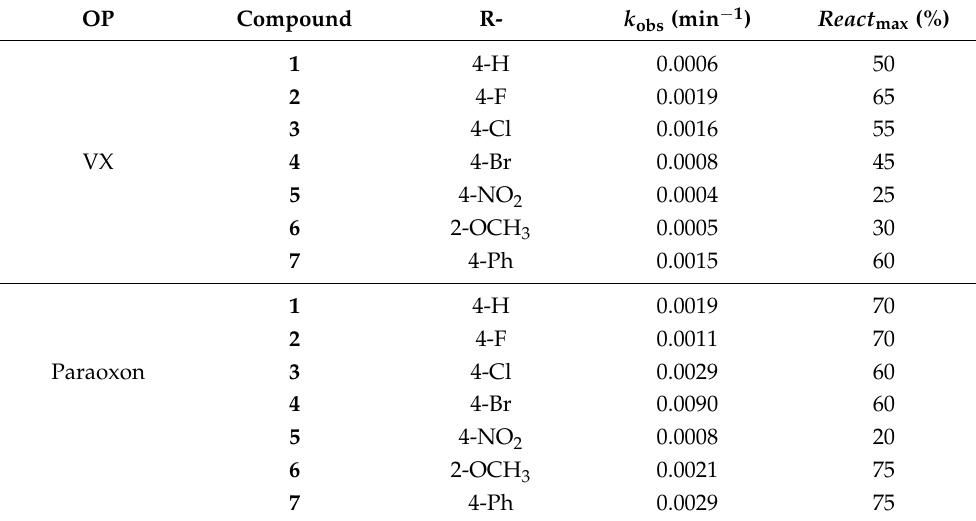
Table 3. Reactivation screening of AChE inhibited by OPs with 1 mM dioximes: first-order re- activation rates, k obs , and maximal reactivation percentage, React max obtained in 24 h. Constants presented as the mean of at least two experiments (standard error was less than 10%, and therefore not indicated).